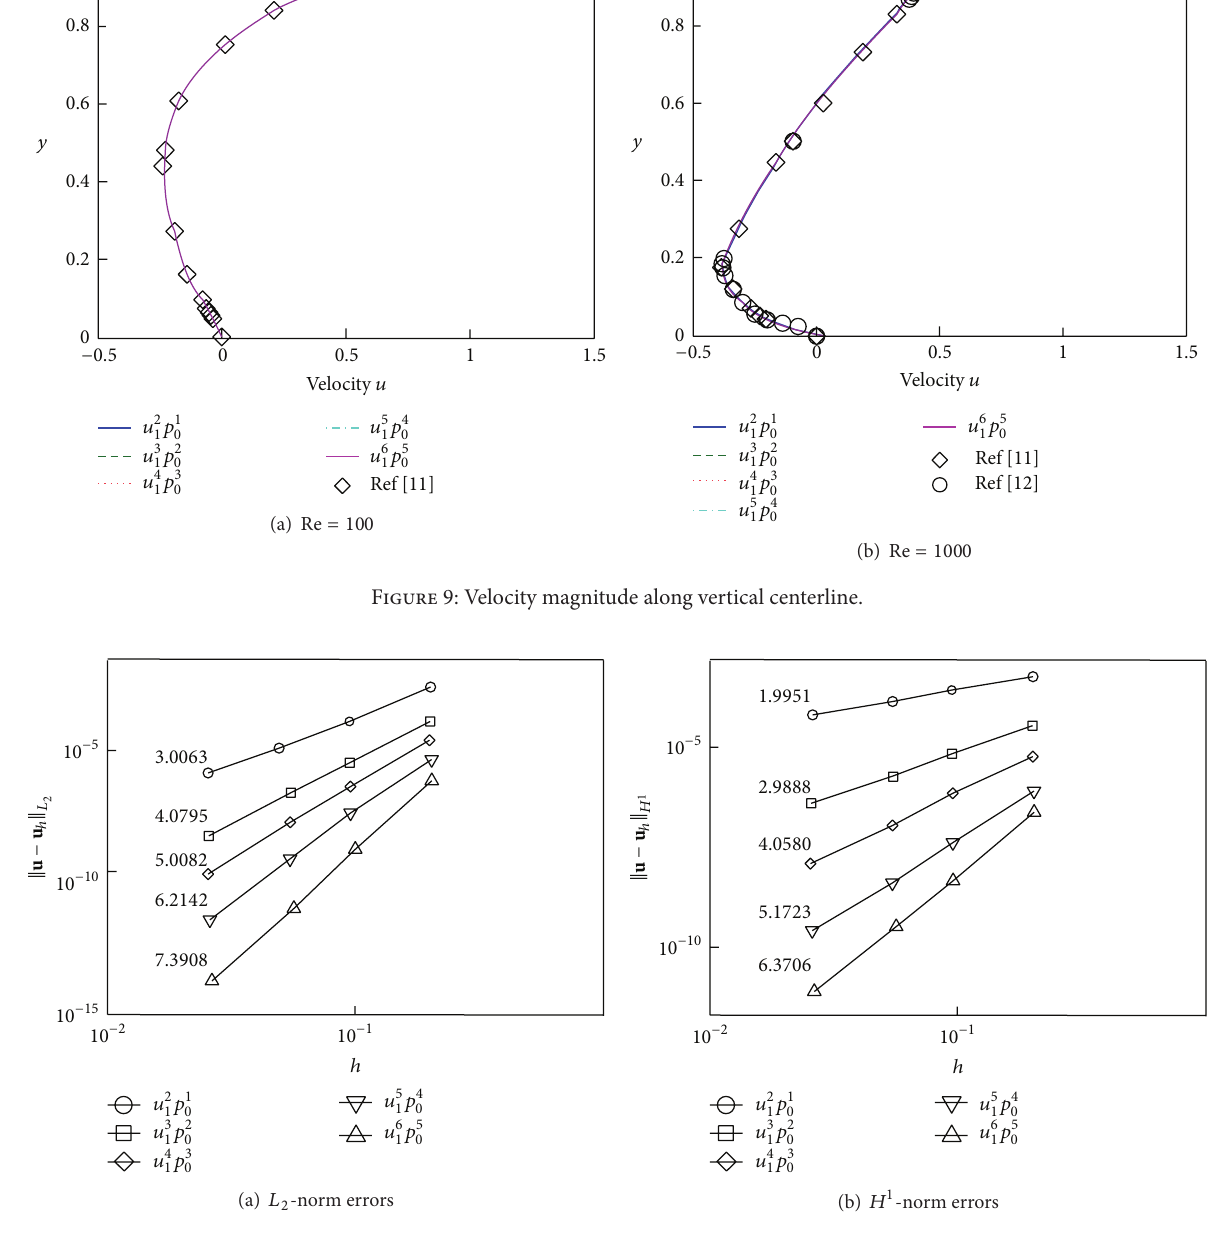
Figure 10: Convergence rate of velocity of Section 5.3.